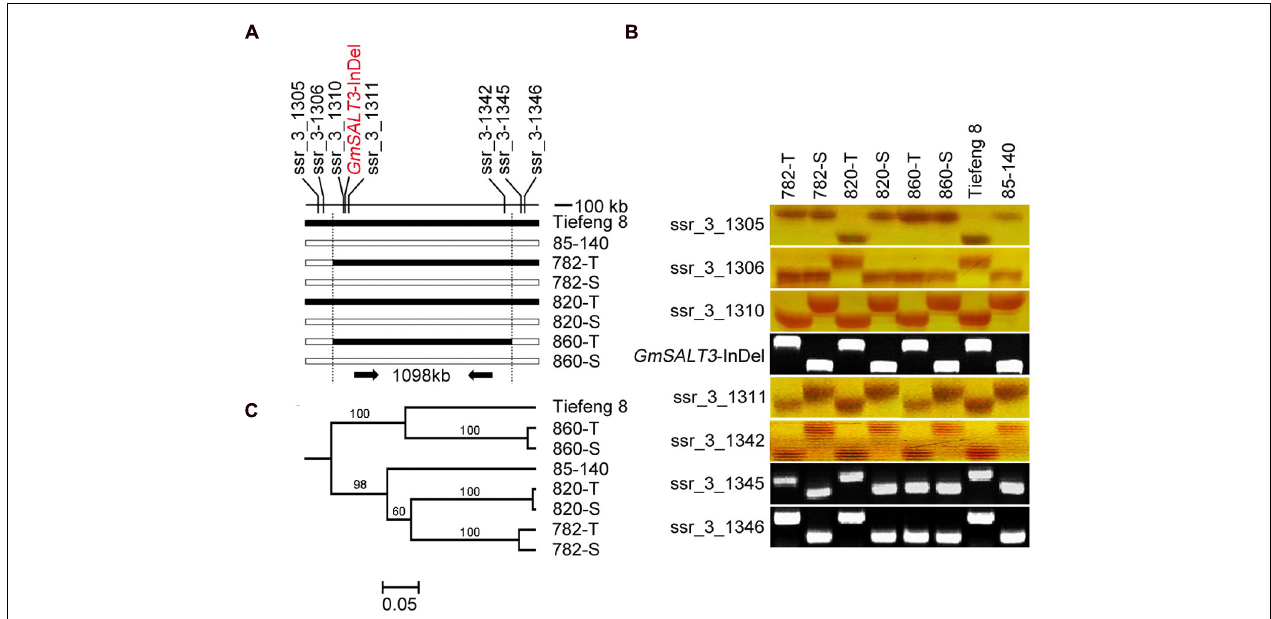
FIGURE 2 | Evaluation of a common region around GmSALT3 and genetic backgrounds of three sets of NILs. (A) Localization of eight markers used for common region testing of three sets of NILs, black bars indicate the same genotype with Tiefeng 8 and the white bars indicate the same genotype with 85–140. The functional marker GmSALT3 -InDel was developed from the variation within the coding region of the target gene GmSALT3 . (B) PCR assays of eight markers on chromosome 3 of NILs and their parents. (C) Phylogenetic relationship of NILs and their parents based on the data of 147 sets of SSR markers using the UPGMA method, the bootstrap values (%) are indicated above the